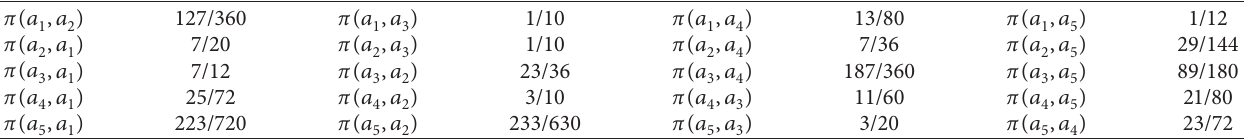
Table 6: Social criteria priority index.